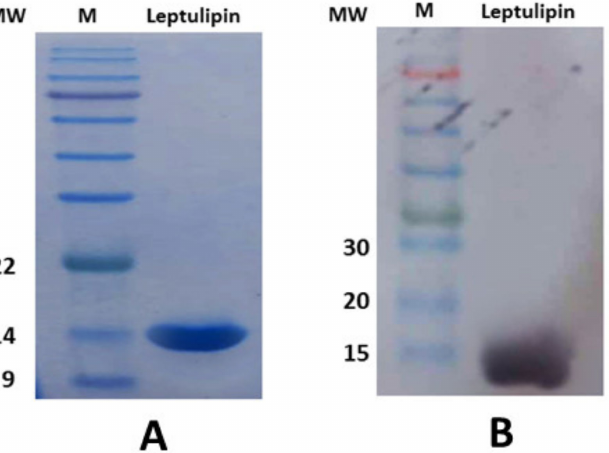
Figure 7. ( A ) SDS-PAGE and ( B ) western blotting of the expressed and purified leptulipin. Purified leptulipin was detected at the molecular weight of ca. 14 kDa.